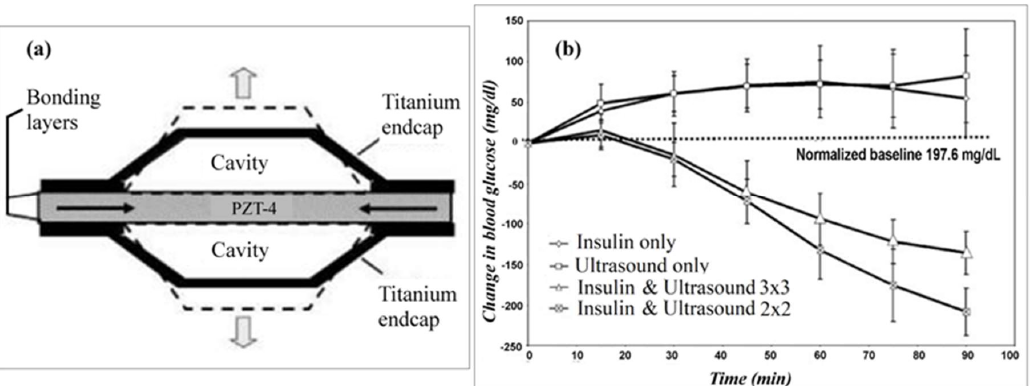
Figure 18. The cymbal transducer made of piezoelectric material lead zirconate-titanate (PZT)-4 operated at a frequency of 20 kHz. The cymbal disk was placed between two titanium caps with air cavities beneath the caps, which convert the radial oscillations of the disk into flexure motions of the caps. Graph of the change in blood glucose over the 90-min transdermal insulin delivery experiment duration, comparing both controls (insulin only and ultrasound only) to the insulin and ultrasound results generated by the 2 × 2 array (insulin and ultrasound 2 × 2) and 3 × 3 array (insulin and ultrasound 3 × 3) [51].